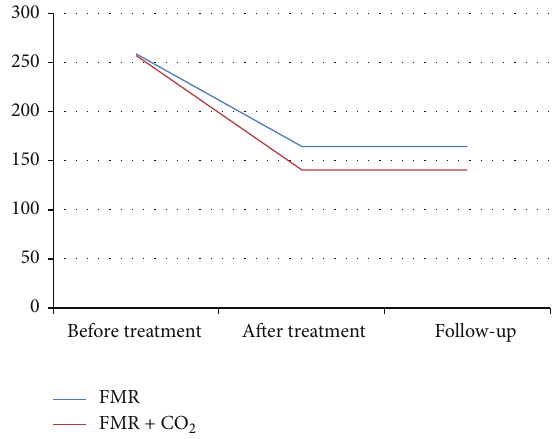
Figure 3: The measured SA area at baseline, after treatment and in the follow-up in FMR and FMR + CO 2